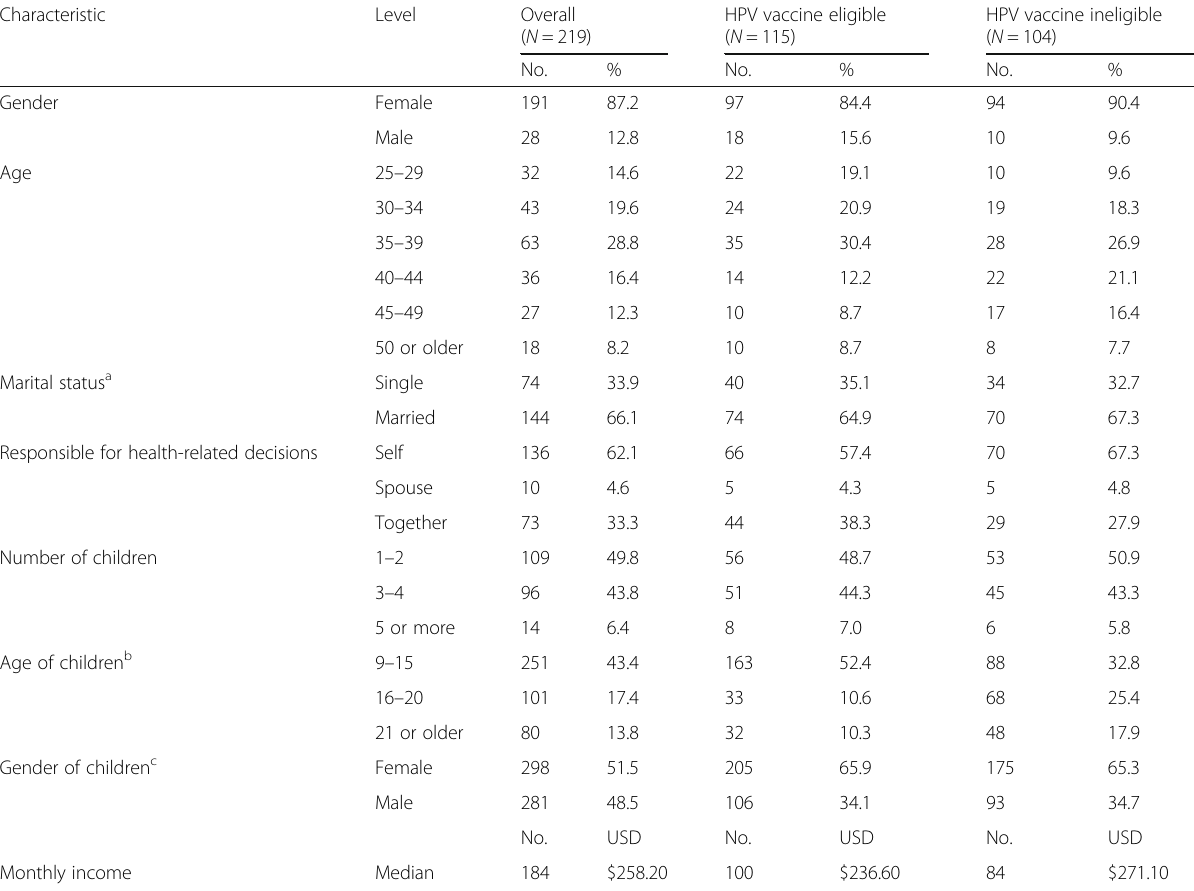
Table 1 Demographic characteristics of parents with children between the ages of 9 and 17 in São Paulo, Brazil, 2015, stratified by child eligibility for the HPV vaccine through SUS Characteristic